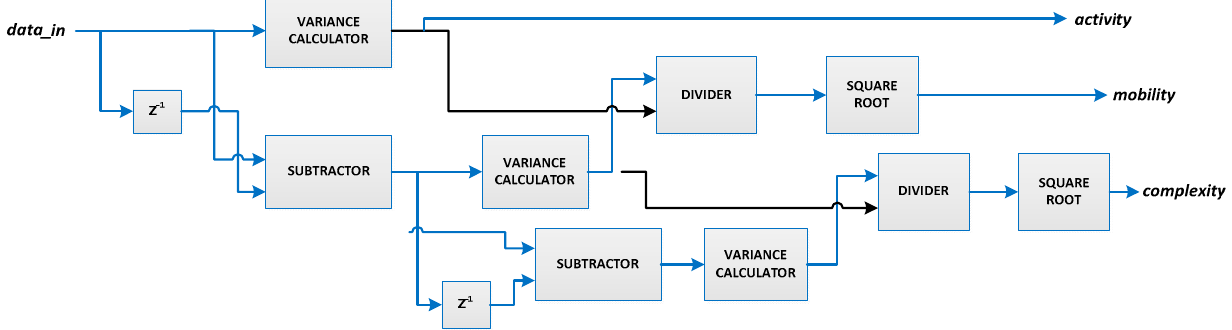
Figure 3. Feature extraction top level architecture to process EEG data input into three Hjorth parameters.